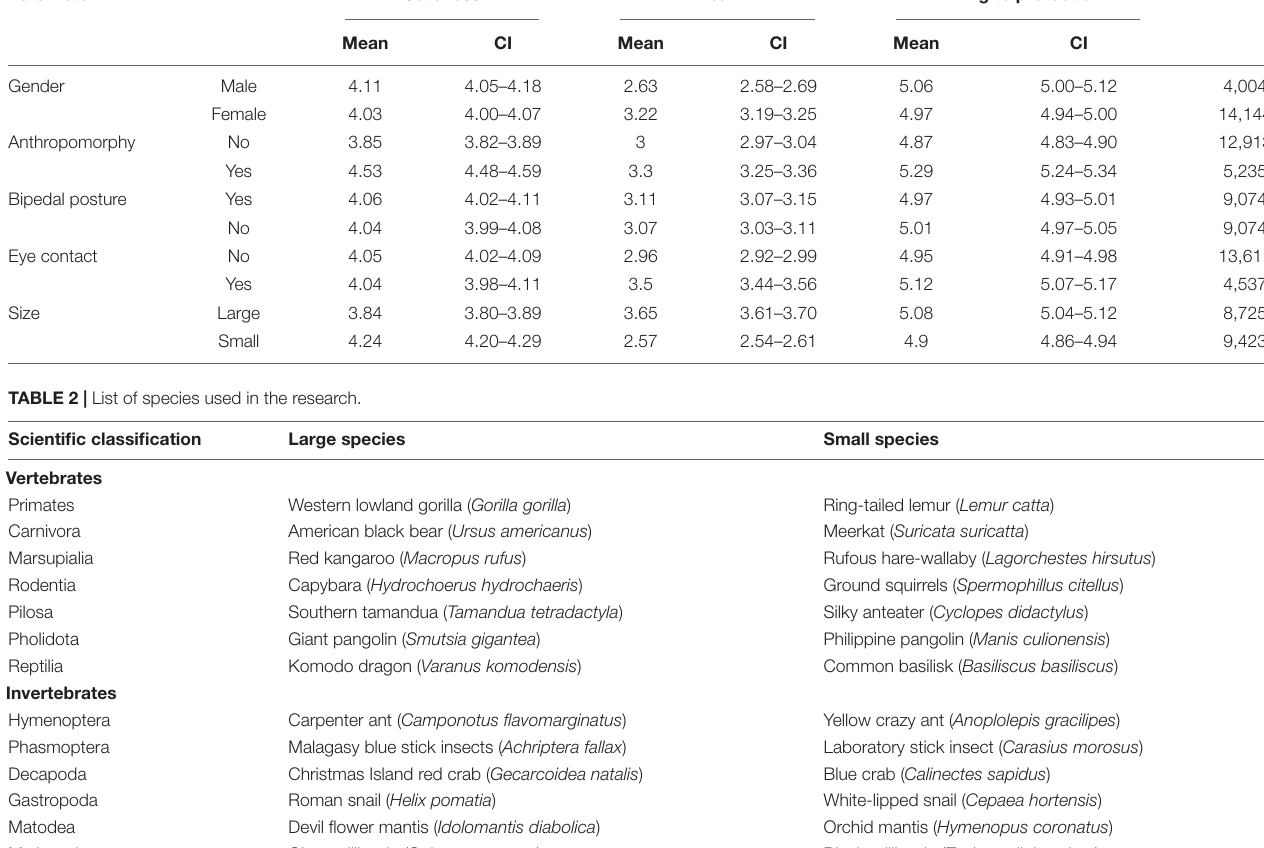
TABLE 1 | Descriptive statistics for cuteness, fear, and willingness to protection ratings of animals. Parameter